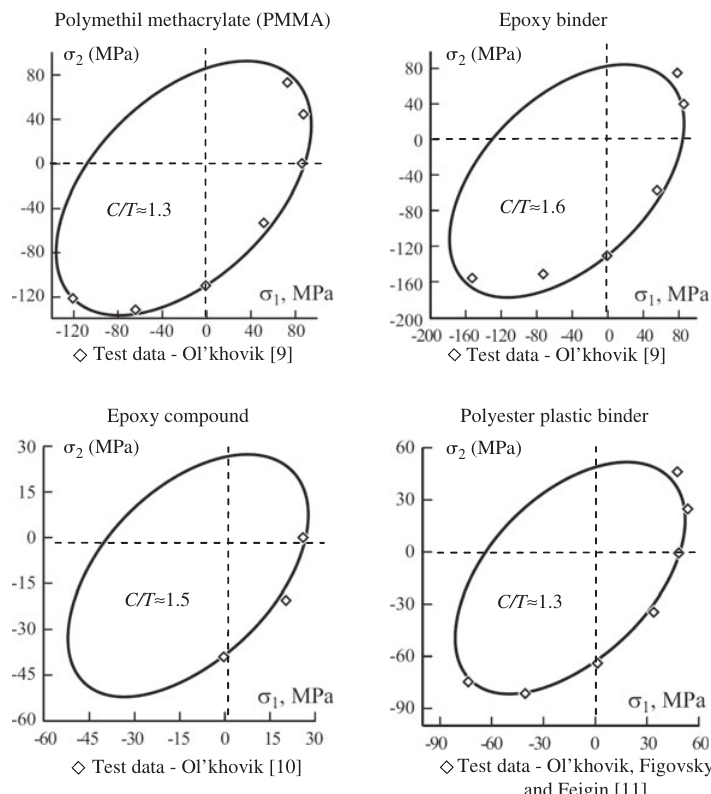
Figure 5 Isotropic failure envelopes for different polymers (adapted from Altenbach and Tushtev [8]